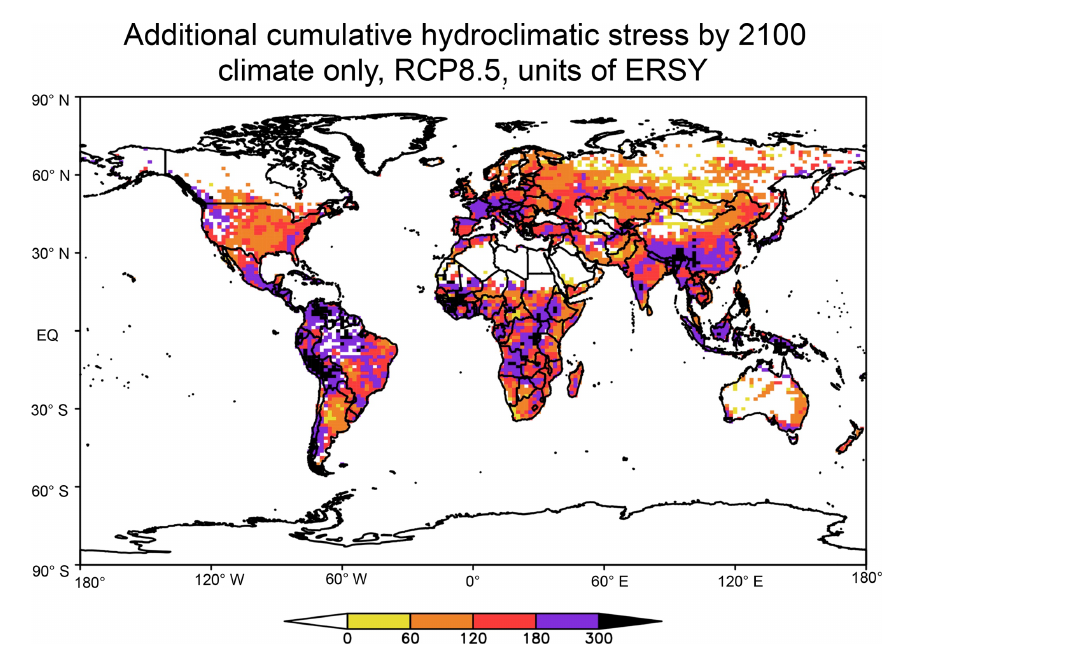
Figure 7. Total number of additional stress years due to increases in wet (R99.9) and dry (D25) events for the period 2011–2100 including only climate variables for the RCP8.5 scenario (see text for more detail). Units are equivalent reference stress years (ERSYs) and the value does not include ERSYs obtained if climate did not change (i.e., for the period 2100–2011 a value of 90).